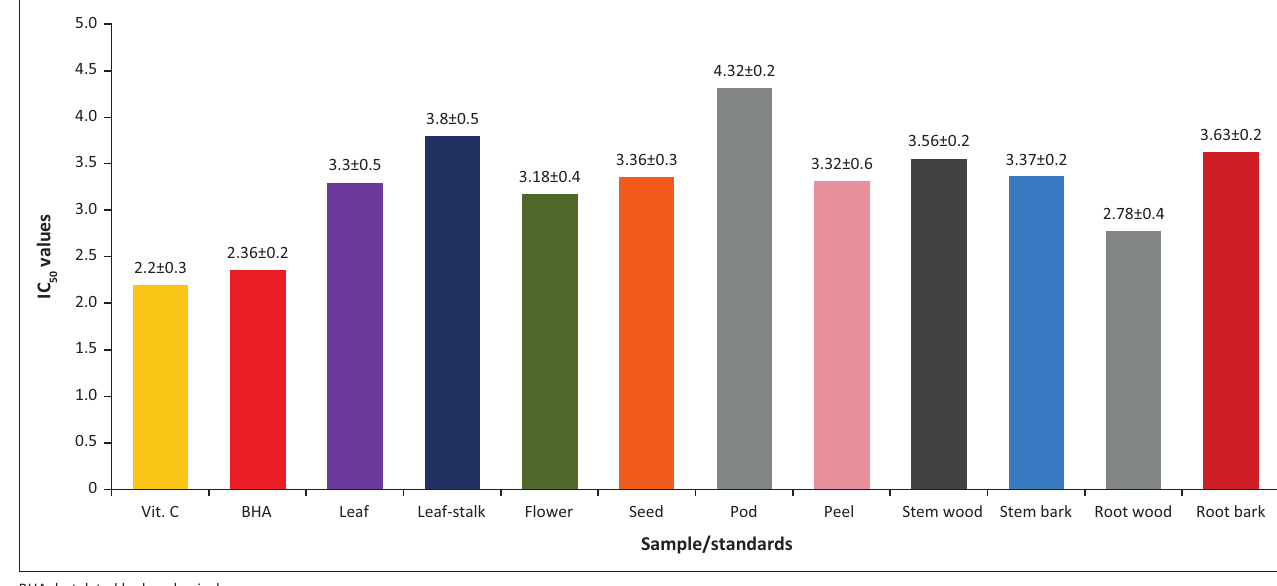
) was obtained in mg/mL using non-linear regression analysis in Microsoft Excel. 50